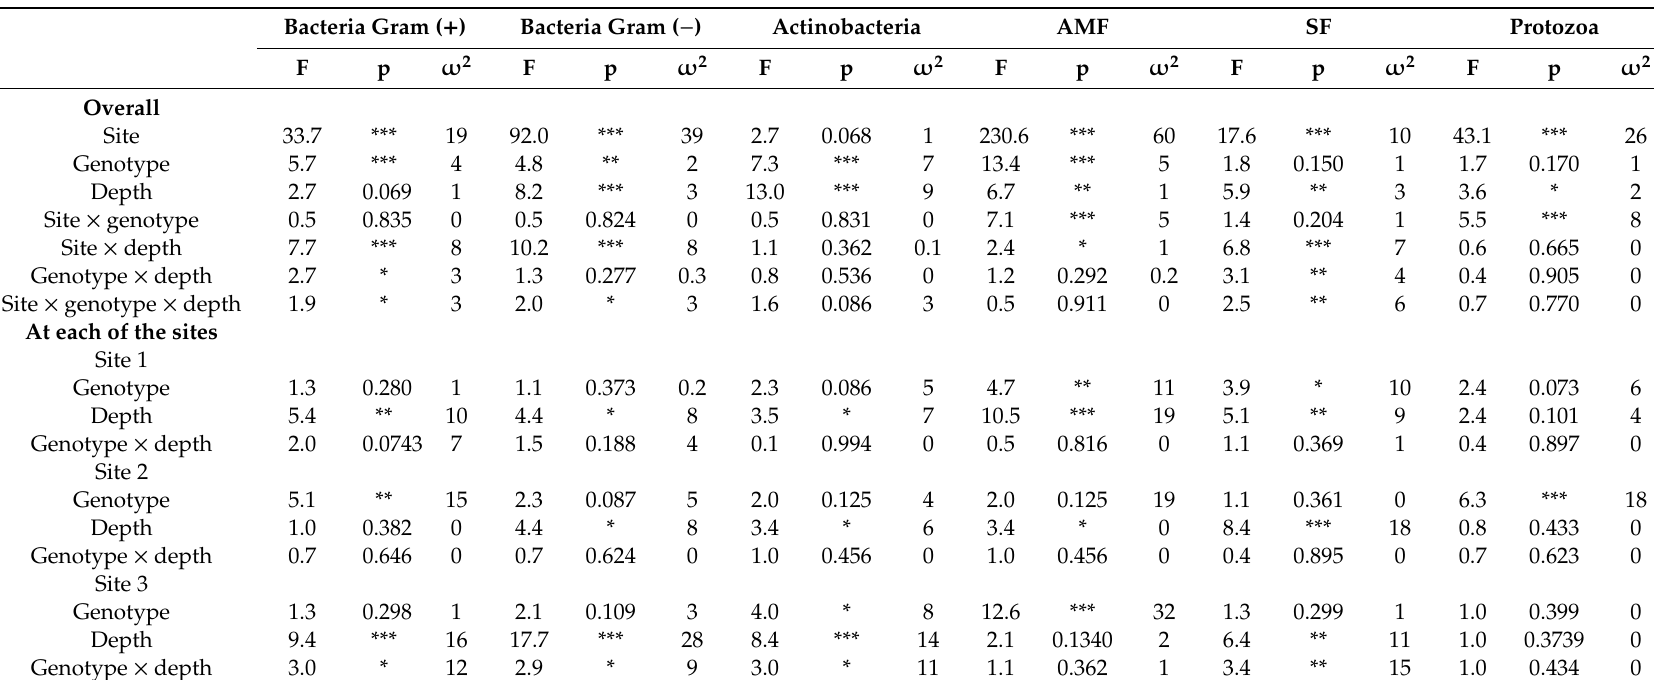
Table 2. Results of ANOVA testing the influence of site, tree genotype, and soil depth on the biomass of soil microorganisms, and the e ff ect size ( ω 2 ) value of these factors. The following symbols are used to indicate level of significance: * p ≤ 0.05; ** p ≤ 0.01 and *** p ≤